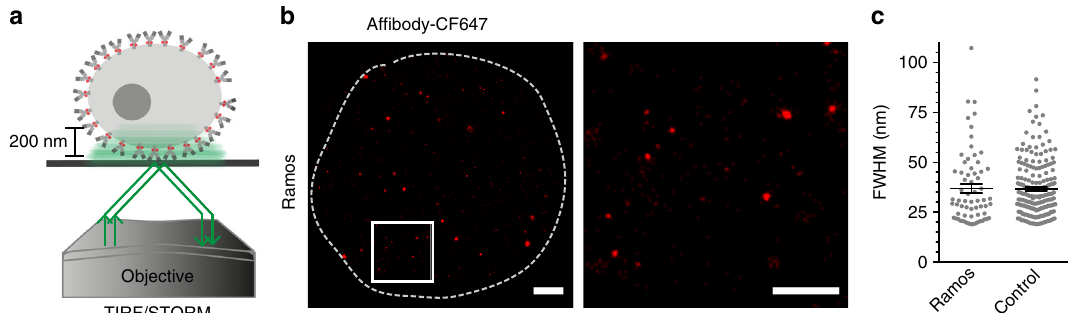
Fig. 2 mIgM-BCRs do not arrange in large protein islands at the plasma membrane. a Schematic depiction of the TIRF/dSTORM setup imaging depth. b Representative TIRF/dSTORM image of an intact Ramos B cell stained with CF TM 647-conjugated anti-IgM af fi bodies. The dotted white trace delineates the area of the plasma membrane close to the glass coverslip imaged under TIRF/dSTORM mode. The white square indicates the zoomed area shown in the image to the right. Scale bars represent 1 µ m and 0.5 µ m for the low and high zoom, respectively. c Scatter plot displaying the spot size (FWHM) distribution unstimulated Ramos cells and as resolution reference the scatter plot of single CF TM 647- af fi bodies spread on a